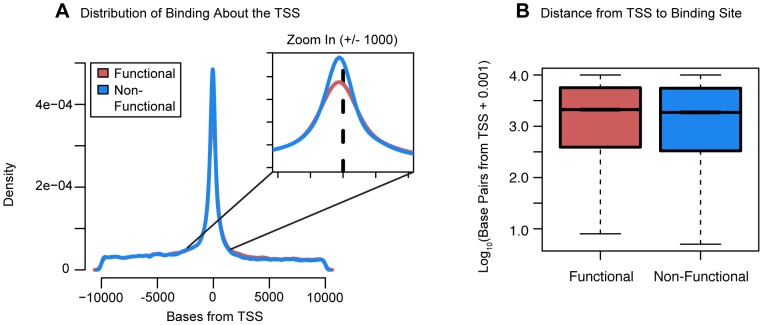
Distribution of functional binding about the TSS.(a) A density plot of the distribution of bound sites within 10 kb of the TSS for both functional and non-functional genes. Inset is a zoom-in of the region +/−1 kb from the TSS (b) Boxplots comparing the distances from the TSS to the binding sites for functionally bound genes and non-functionally bound genes. For the boxplots, 0.001 was added before log10 transforming the distances and outliers were not plotted.